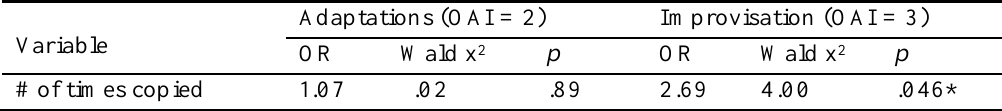
Table 9 Multinomial Logistic Regression on OAI Score for 51 Public IA Projects